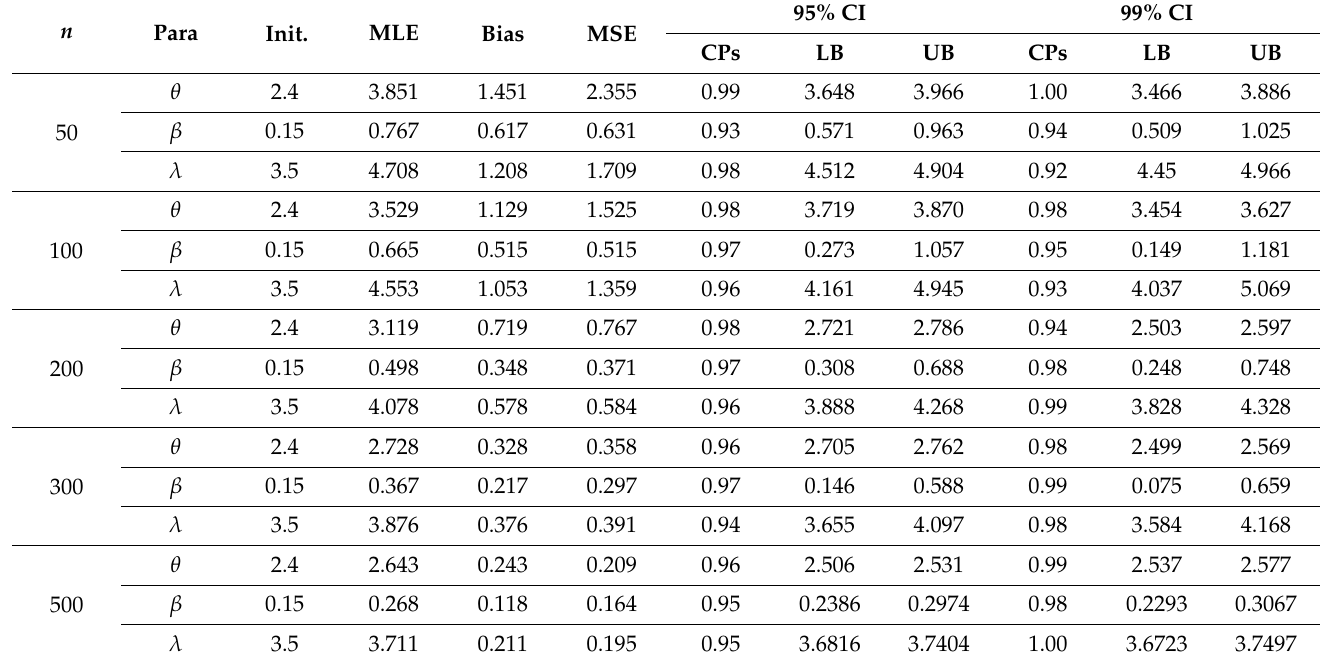
Table 5. The MLEs, Bias, MSE, and CPs for the model parameters of the minLLx distribution based on some initial (Init)